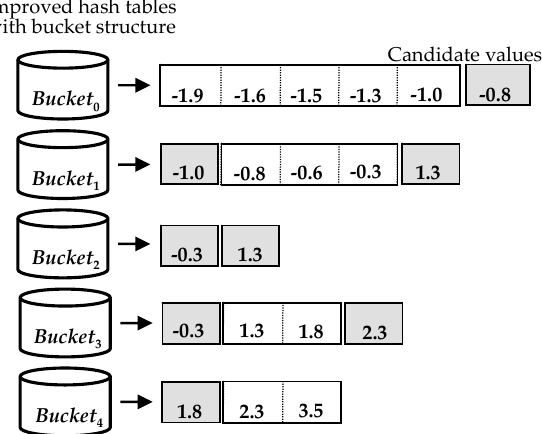
Figure 6. Construction of improved hash tables for quick search.